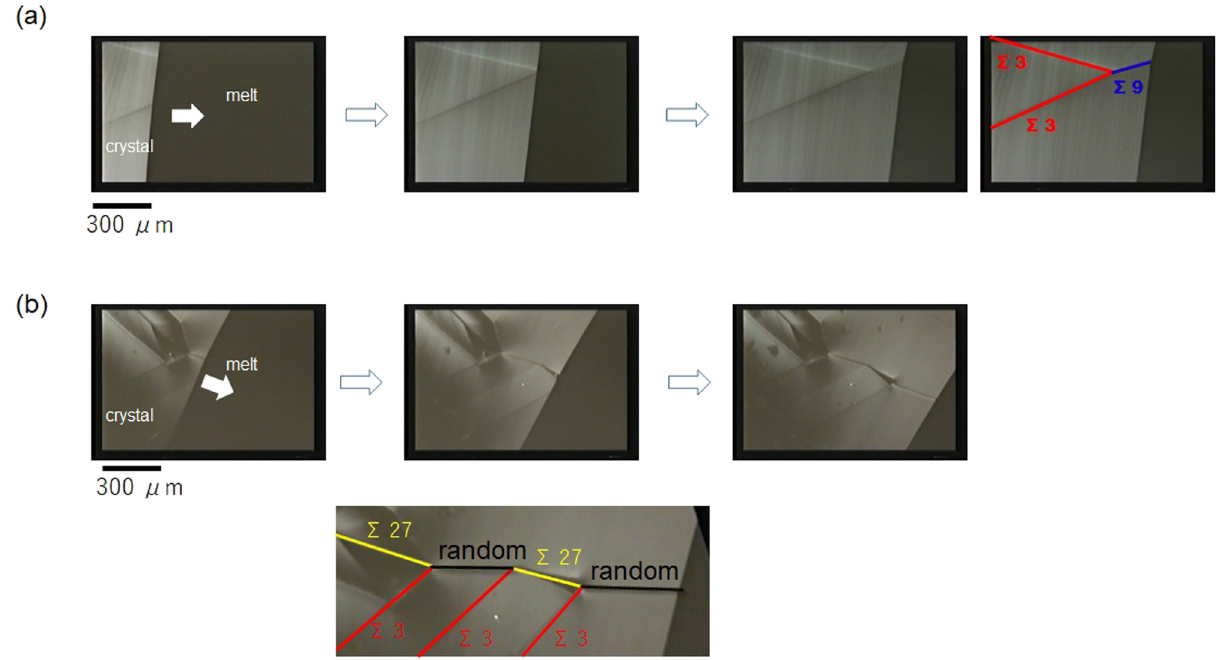
Figure 14: Observations of grain boundary impingement: ( a ) two Σ 3 grain boundaries impinge at the interface, and a Σ 9 grain boundary is formed and ( b ) a Σ 27 grain boundary and a Σ 3 grain boundary produce a random grain boundary after the impingement, and a random grain boundary and a Σ 3 grain boundary produce a Σ 27 grain boundary after the